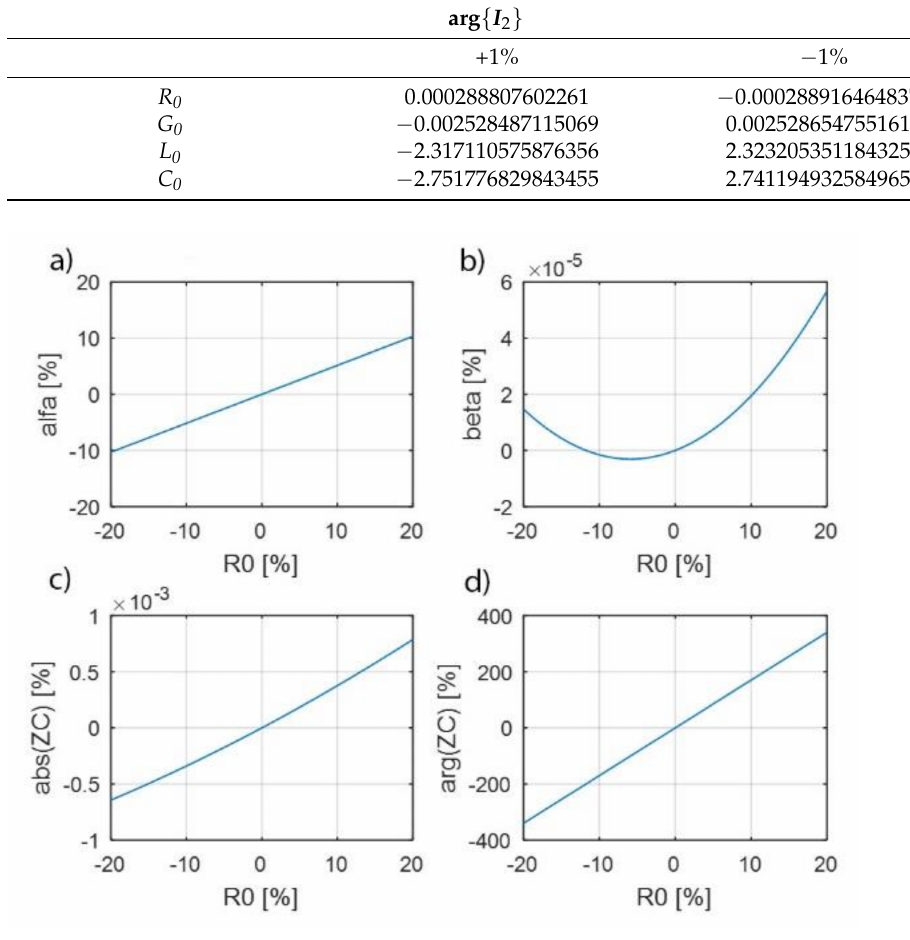
Figure 2. Changes of wave parameters depending on R 0 at f = 100 kHz; ( a ) damping factor α , ( b ) phase factor β , ( c ) wave impedance modulus, and ( d ) wave impedance argument. Changes to the damping factor alpha when changing parameter L 0 are non − linear, and vary from 1% to 0.2%, regardless of frequency (Figures 5a, 6a and 7a). The factor β rises almost linearly from − 10% to 10%, regardless of frequency (Figures 5b, 6b and 7b). The impedance modulus rises almost linearly in the range of − 10% to 10% for all tested frequen- cies (Figures 5c, 6c and 7c). The argument changes linearly in the range from approximately 200% to − 400%, with minor changes for individual frequencies (Figures 5d, 6d and